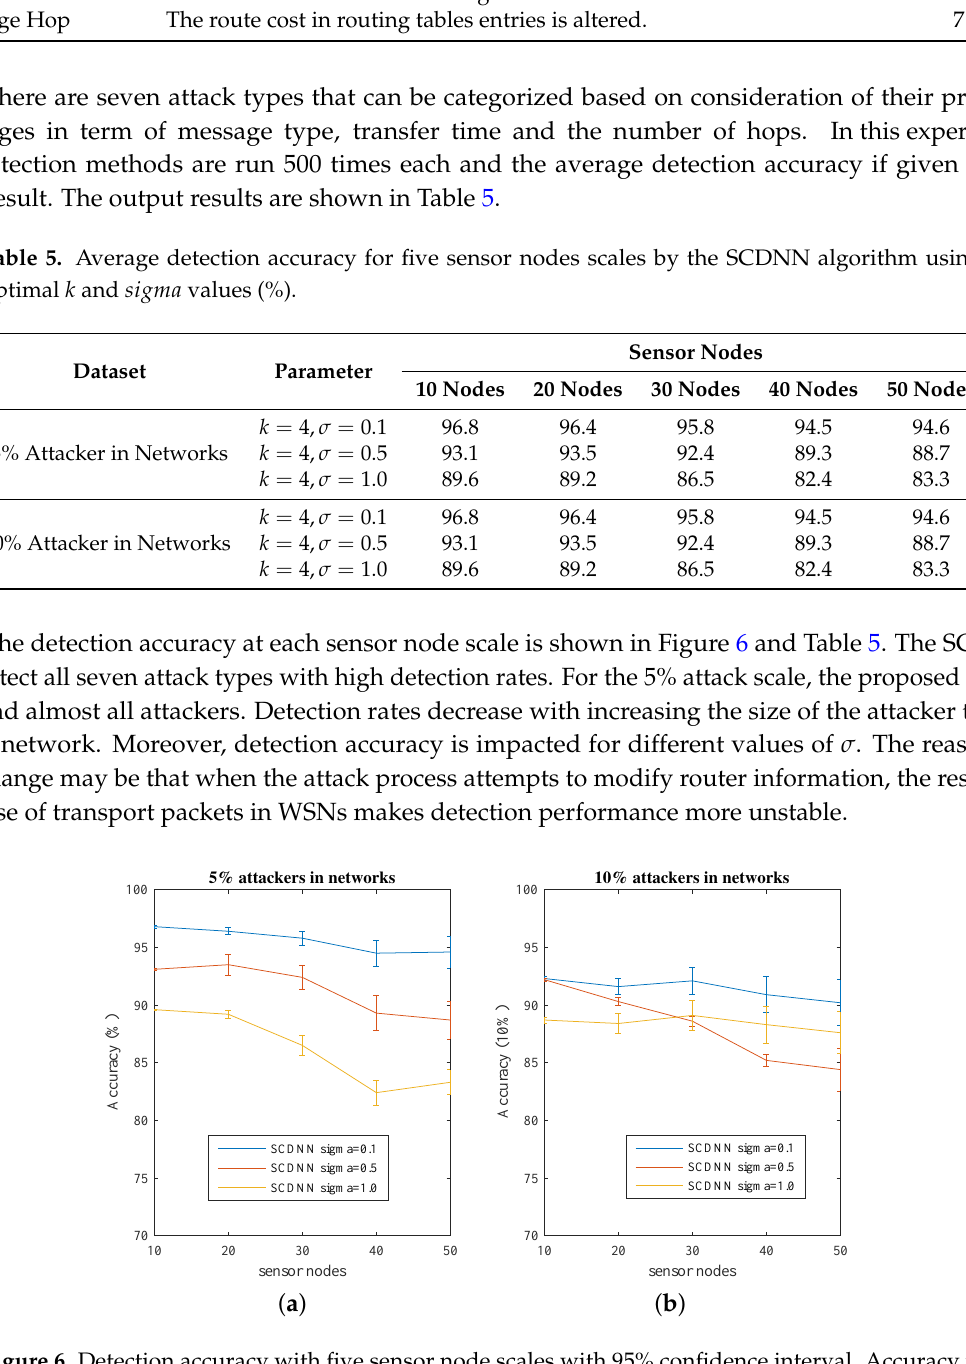
Figure 6. Detection accuracy with five sensor node scales with 95% confidence interval. Accuracy is shown for ( a ) a 5% attacker and ( b ) a 10% attacker, 500 times